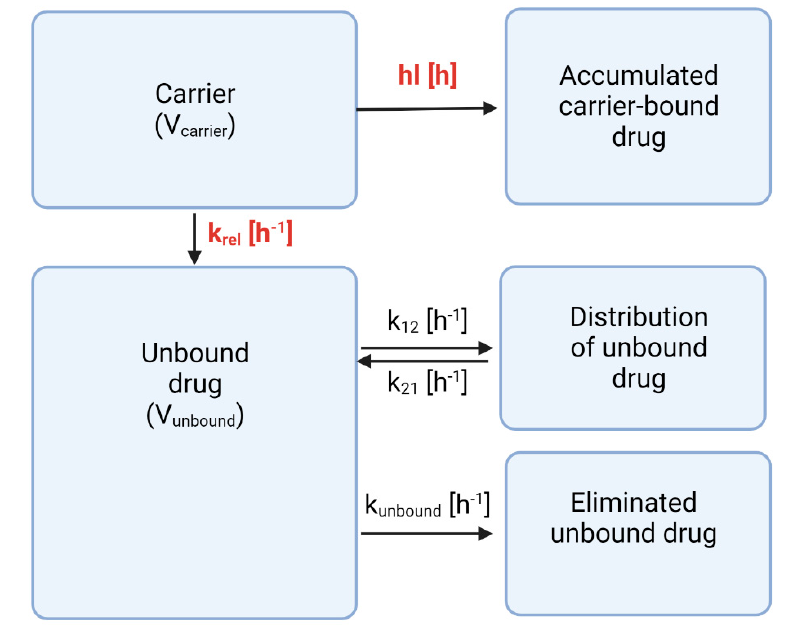
Figure 5. Illustration of the PBNB model that was used for the compartmental analysis (hl = Carrier half-life; krel = Release rate of doxorubicin in vivo; V carrier = Volume of distribution of the carrier; V unbound = Volume of distribution of doxorubicin; k12, k21 = Circulation and recirculation rates